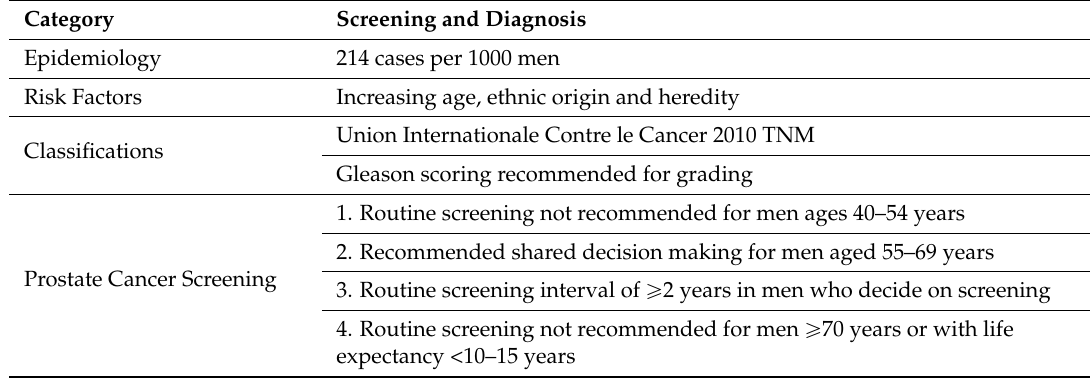
Table 1. European Association of Urology Guidelines for Prostate Cancer Screening, Diagnosis and